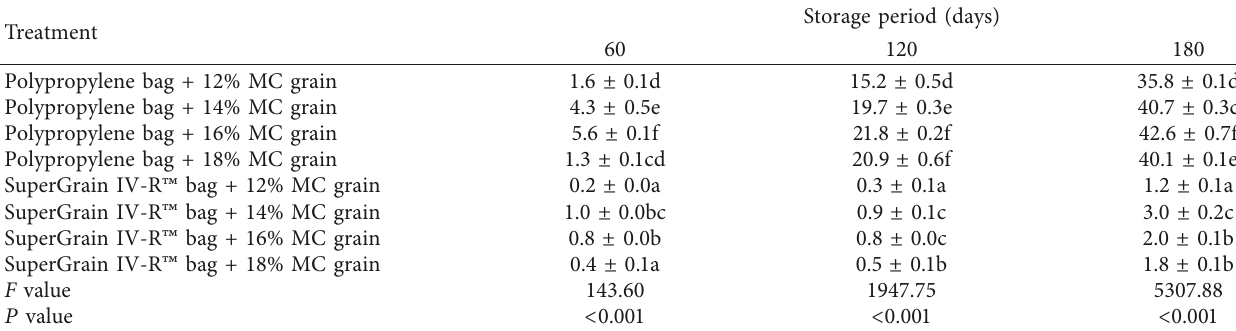
Table 5: Mean ( ± SE) percentage weight loss after 60, 120, and 180 days of storage. Treatment